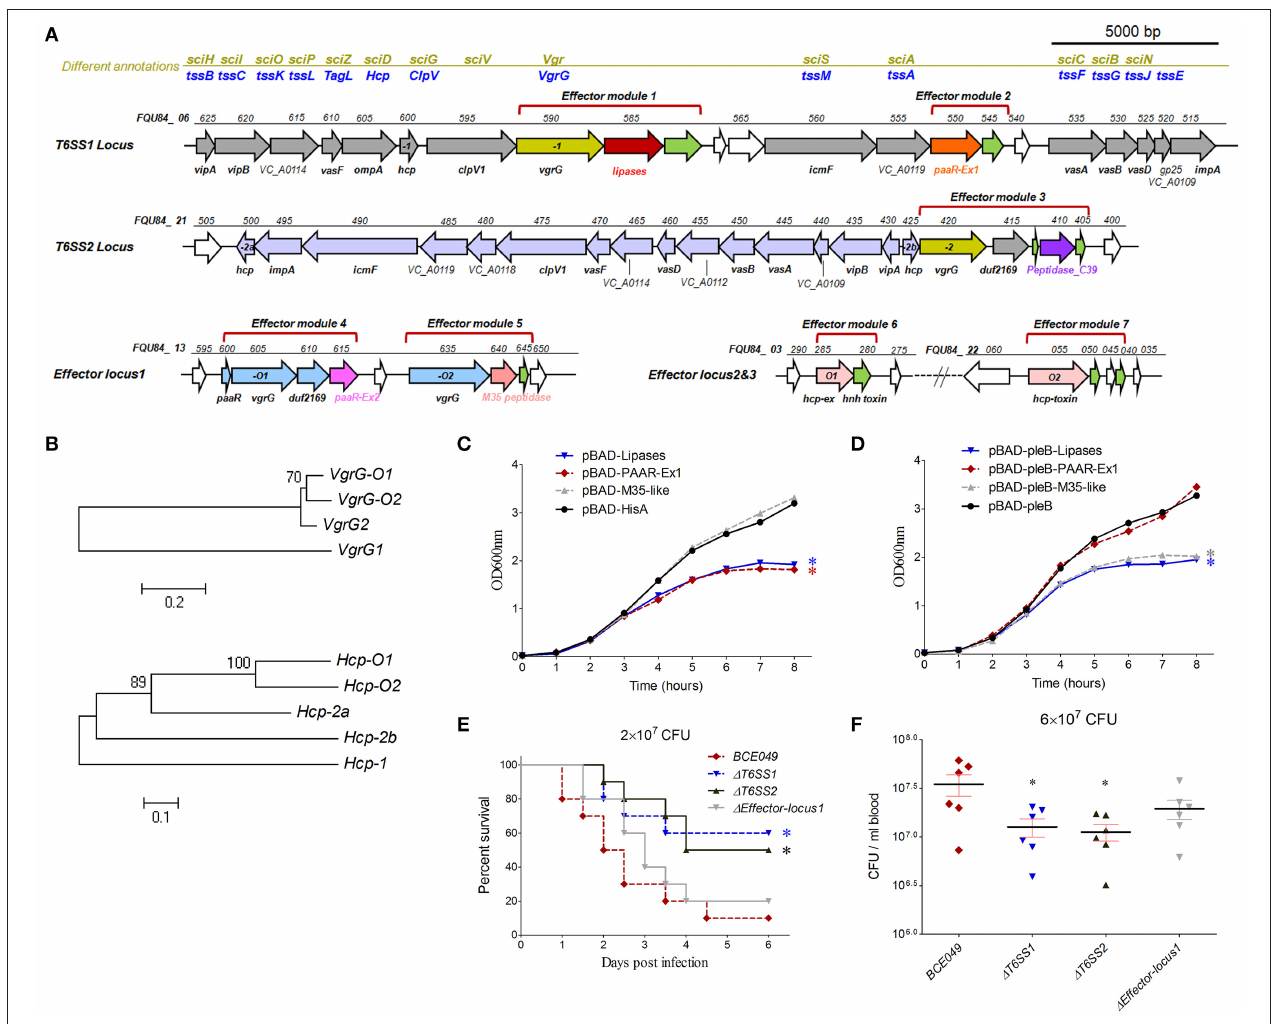
FIGURE 4 | The role of T6SSs and predicted effectors in interbacterial competition and pathogenicity. (A) Schematic diagram of the genetic organization in two T6SS loci and three predicted effector loci. (B) The evolutionary relationships among VgrGs encoded within effector locus1 and T6SS loci in strain BCE049 (upper panel), and among Hcps encoded within effector locus2, locus3, and T6SS loci (lower panel). The protein sequences were aligned with ClustalW, and the MEGA software version 5.0 was used to perform a 1,000-bootstrap phylogenetic analysis using the neighbor joining method. (C,D) Growth curves of E. coli cells producing lipase, PAAR-Ex1 and M35-peptidase using pBAD-hisA or pBAD-pleB plasmids. The periplasmic localization of proteins using plasmid pBAD-pleB was achieved by fusion to the PelB leader sequence (48). The cultures were induced by L -arabinose at the indicated time (shown by the red arrow). The experiments were run in triplicate. The data were compared with that of strain with the vector pBAD-hisA or pBAD-pleB and analyzed using the one-way ANOVA test (* P < 0.05). (E) Effect of hlyCABD and CNF2 on ExPEC BCE049 pathogenicity. Survival curve of mice infected with 2 × 10 7 CFU/mouse bacteria (10 5-week-old mice per group). The data were compared with that of strain BCE049 and analyzed using the log-rank (Mantel–Cox) test (* P < 0.05). (F) Systemic infection experiments were conducted to assess bacterial proliferation in mouse blood. Bacterial reisolation from the blood at 12h postinoculation was quantified by plate count. Statistical significance was determined by a Student t -test based on comparisons with the wild-type group (* P <